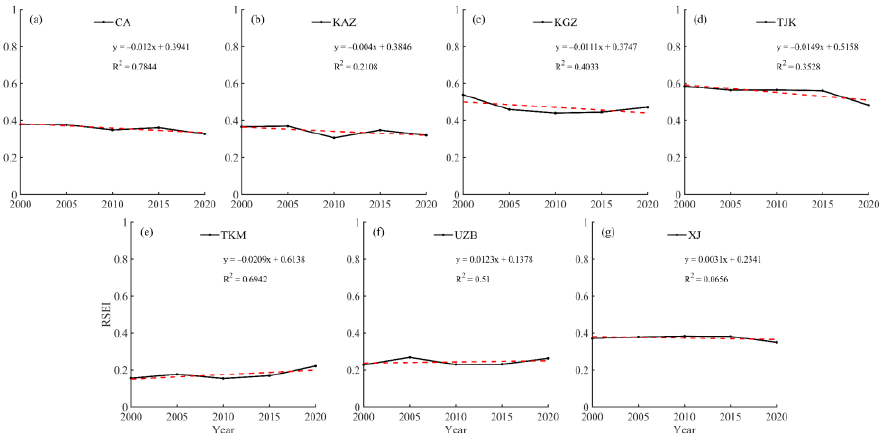
Figure 4. Interannual variation in the mean RSEI throughout CA and its six regions (( a – g ) are CA, KAZ, KGZ, TJK, TKM, UZB, and XJ,